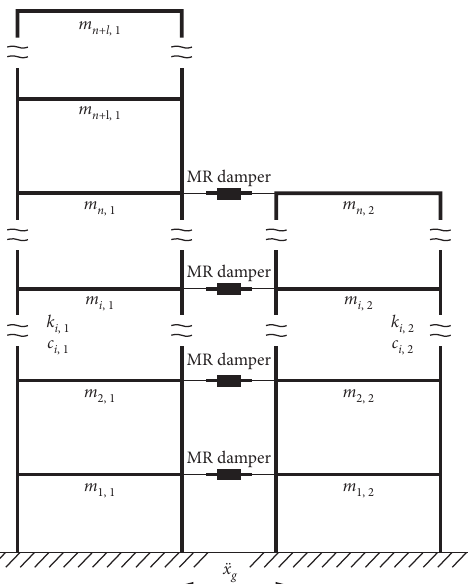
Figure 1: Schematic diagram of the MR dampers-coupled adjacent dampers. Building 1 (the right building) and Building 2 (the left building) have ( n + l ) stories and n stories, respectively.